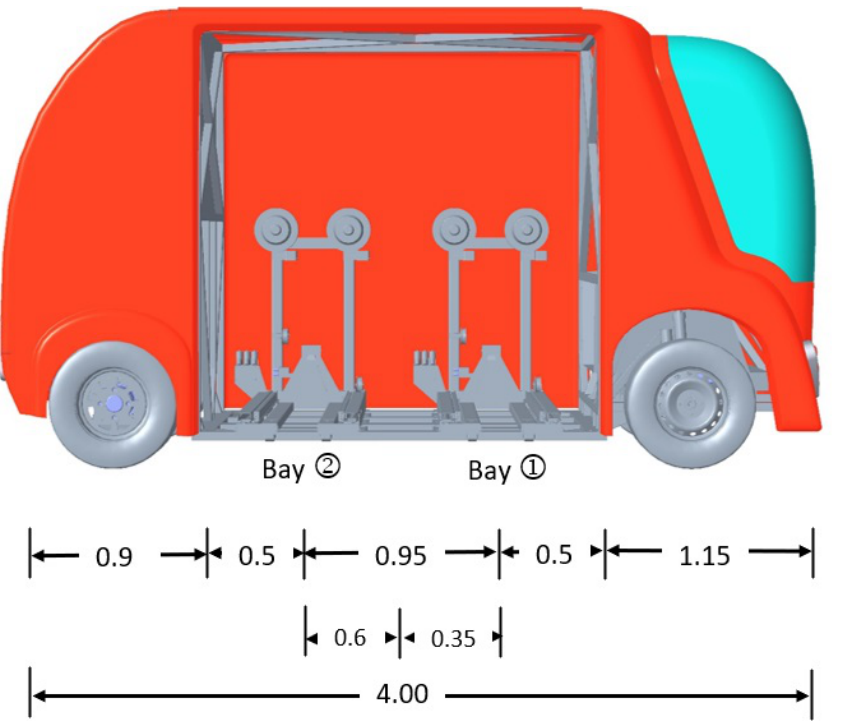
Figure 4. Vehicle dimensions w.r.t loading bays.